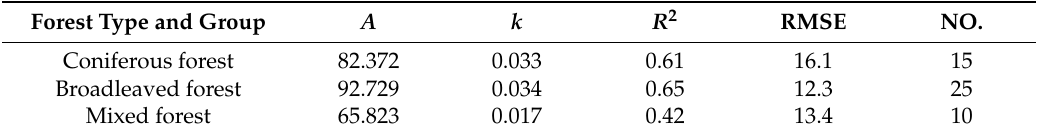
Table 5. Coefficient estimates and goodness-of-fit statistics of the NPP und